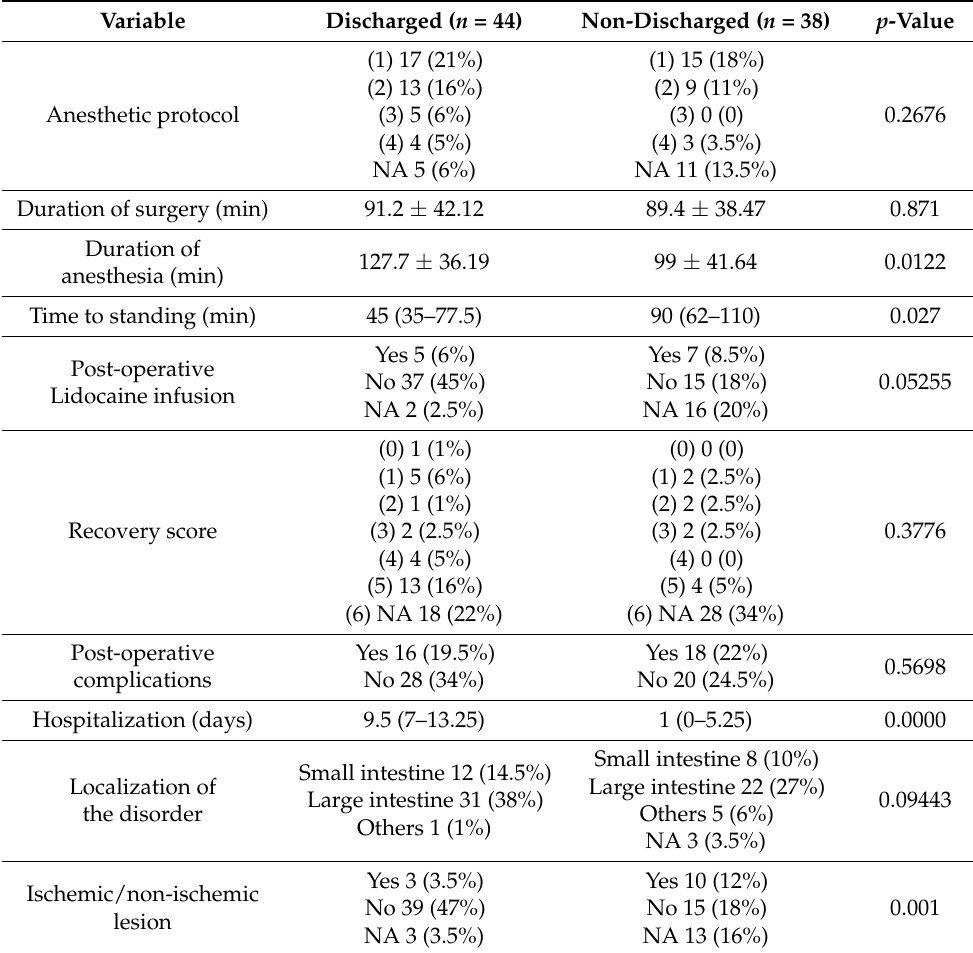
Table 9. Perioperative variables of the Surgery group according to the outcome. Duration of anesthe- sia, time to standing, administration of post-operative lidocaine, duration of hospitalization, and the presence of an ischemic disorder was significantly different between discharged and non-discharged horses. Statistical significance was set at p <